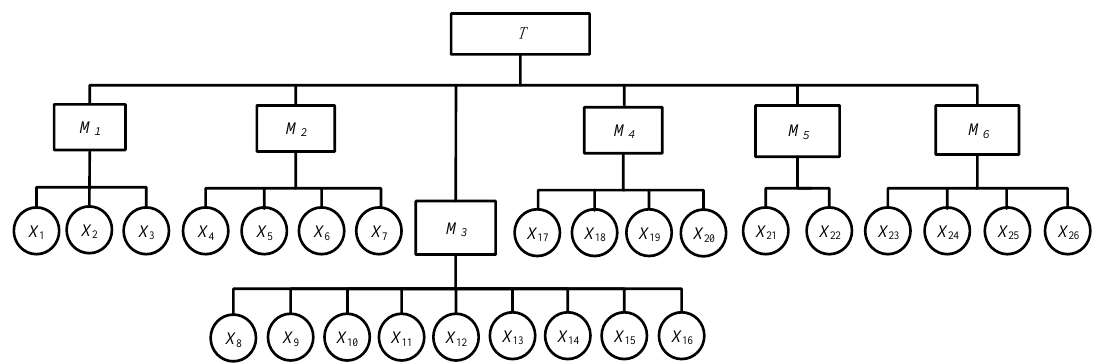
Figure 2. Indicators to monitor pipeline failure.